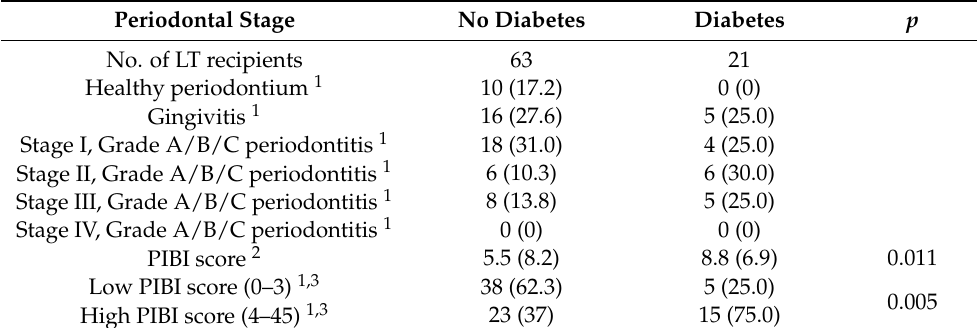
Table 4. Distribution of stage of periodontitis and periodontal inflammatory burden index in liver transplant recipients with no diabetes and with diabetes, after liver